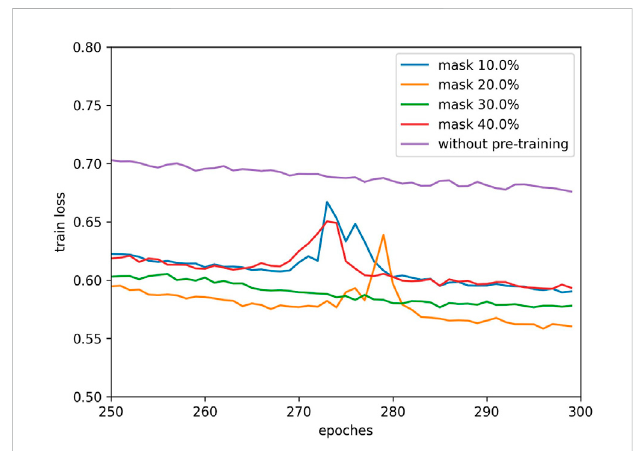
FIGURE 7 Training loss on the training dataset.